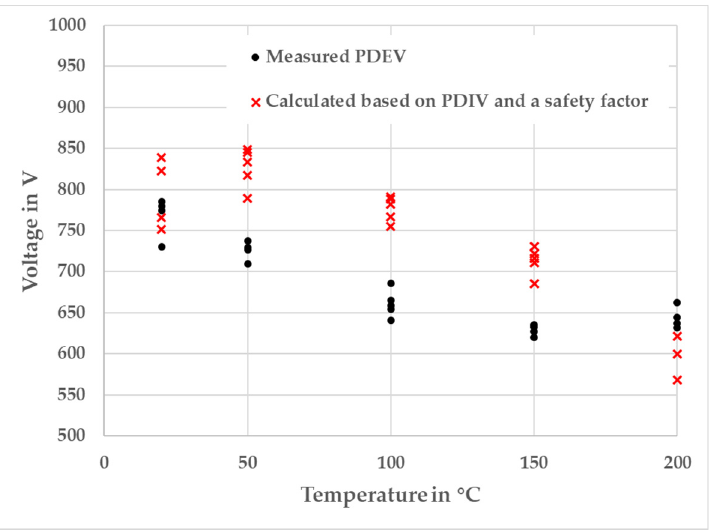
Figure 13. Measured and calculated PDEV based on the safety factor at different temperature [155].